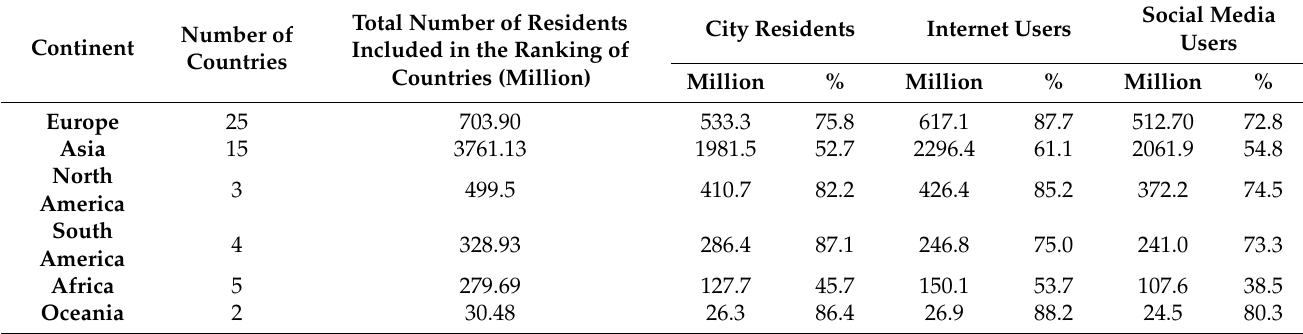
Table 4. SC Index 2020 and the importance of the Internet and social networks on individual